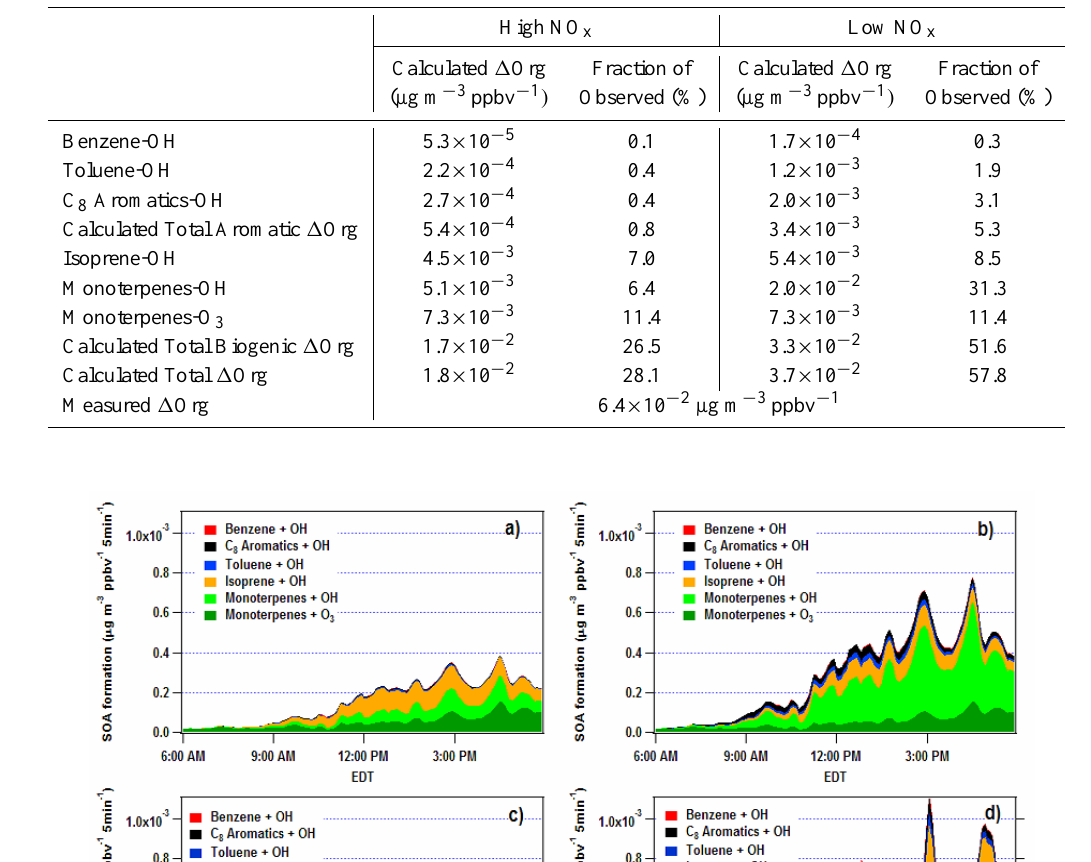
Table 3. Calculated Contributions to Secondary Organic Aerosol Formation for the Full Campaign less the Detroit Air period (all normalized to CO).